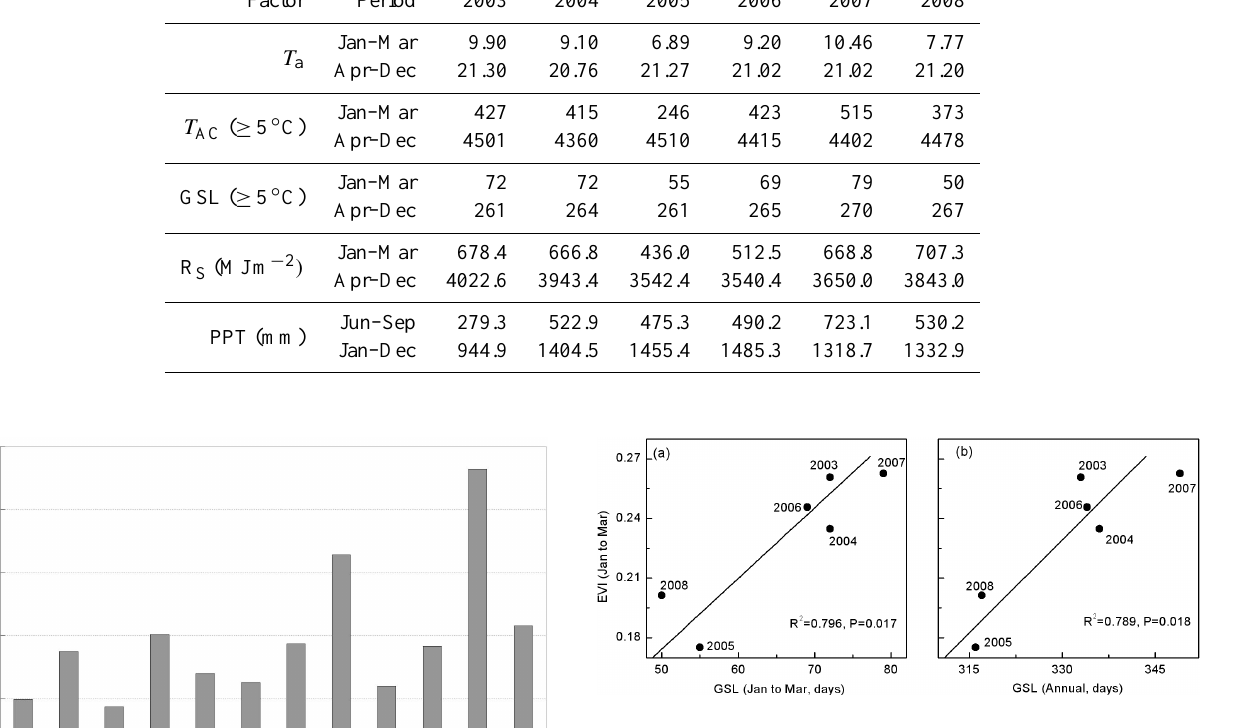
Fig. 5. Relations of the averaged MODIS EVI from January to March with the concurrent growing season length (GSL) and the annual GSL during 2003–2008 at QYZ